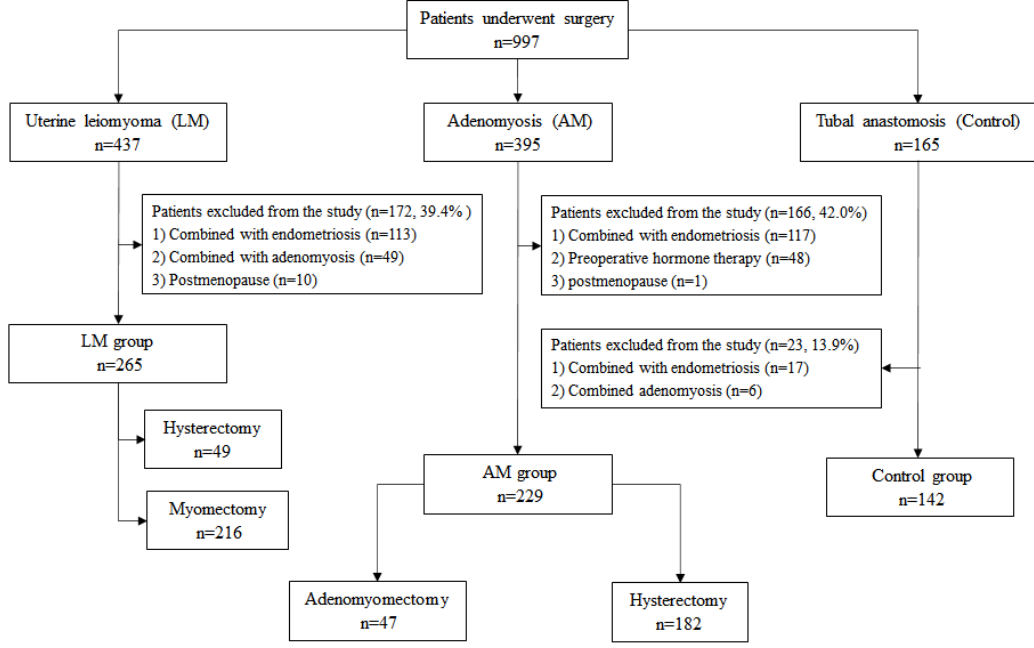
Figure 1. Study flow diagram.